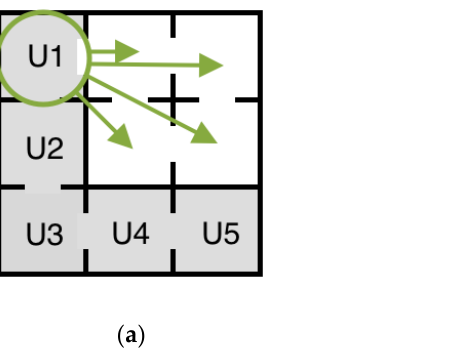
Figure A2. ( a ): Example showing the patches (indicated by arrows) used to calculate configuration for U1 (circled) (e.g., distance between U1 and all disturbed patches (in white)), with the average distance from U1 to U5 used to provide a configuration value; ( b ): Example system showing the probability in each undisturbed patch that the crab will move in the right direction toward a disturbed patch.